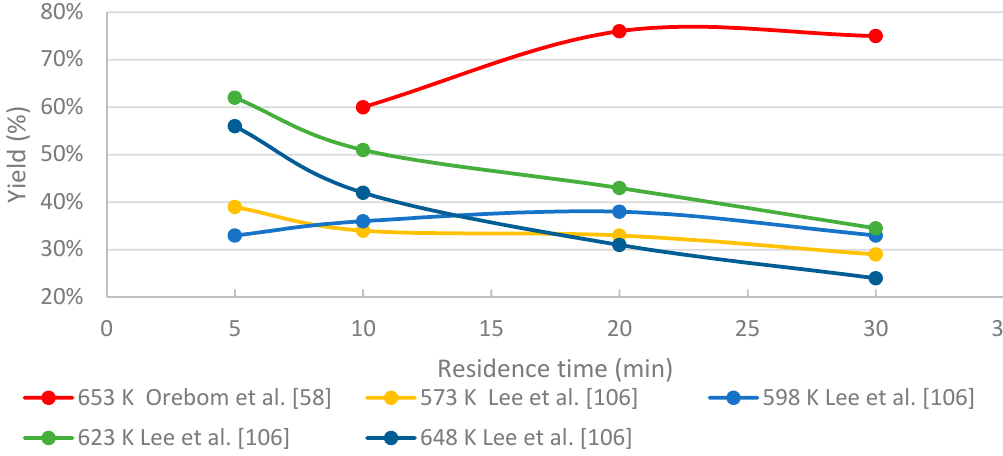
Figure 10. Bio-oil yield as a function of residence time. All the experiments were performed in batch reactors. The curves are guides to the eye.